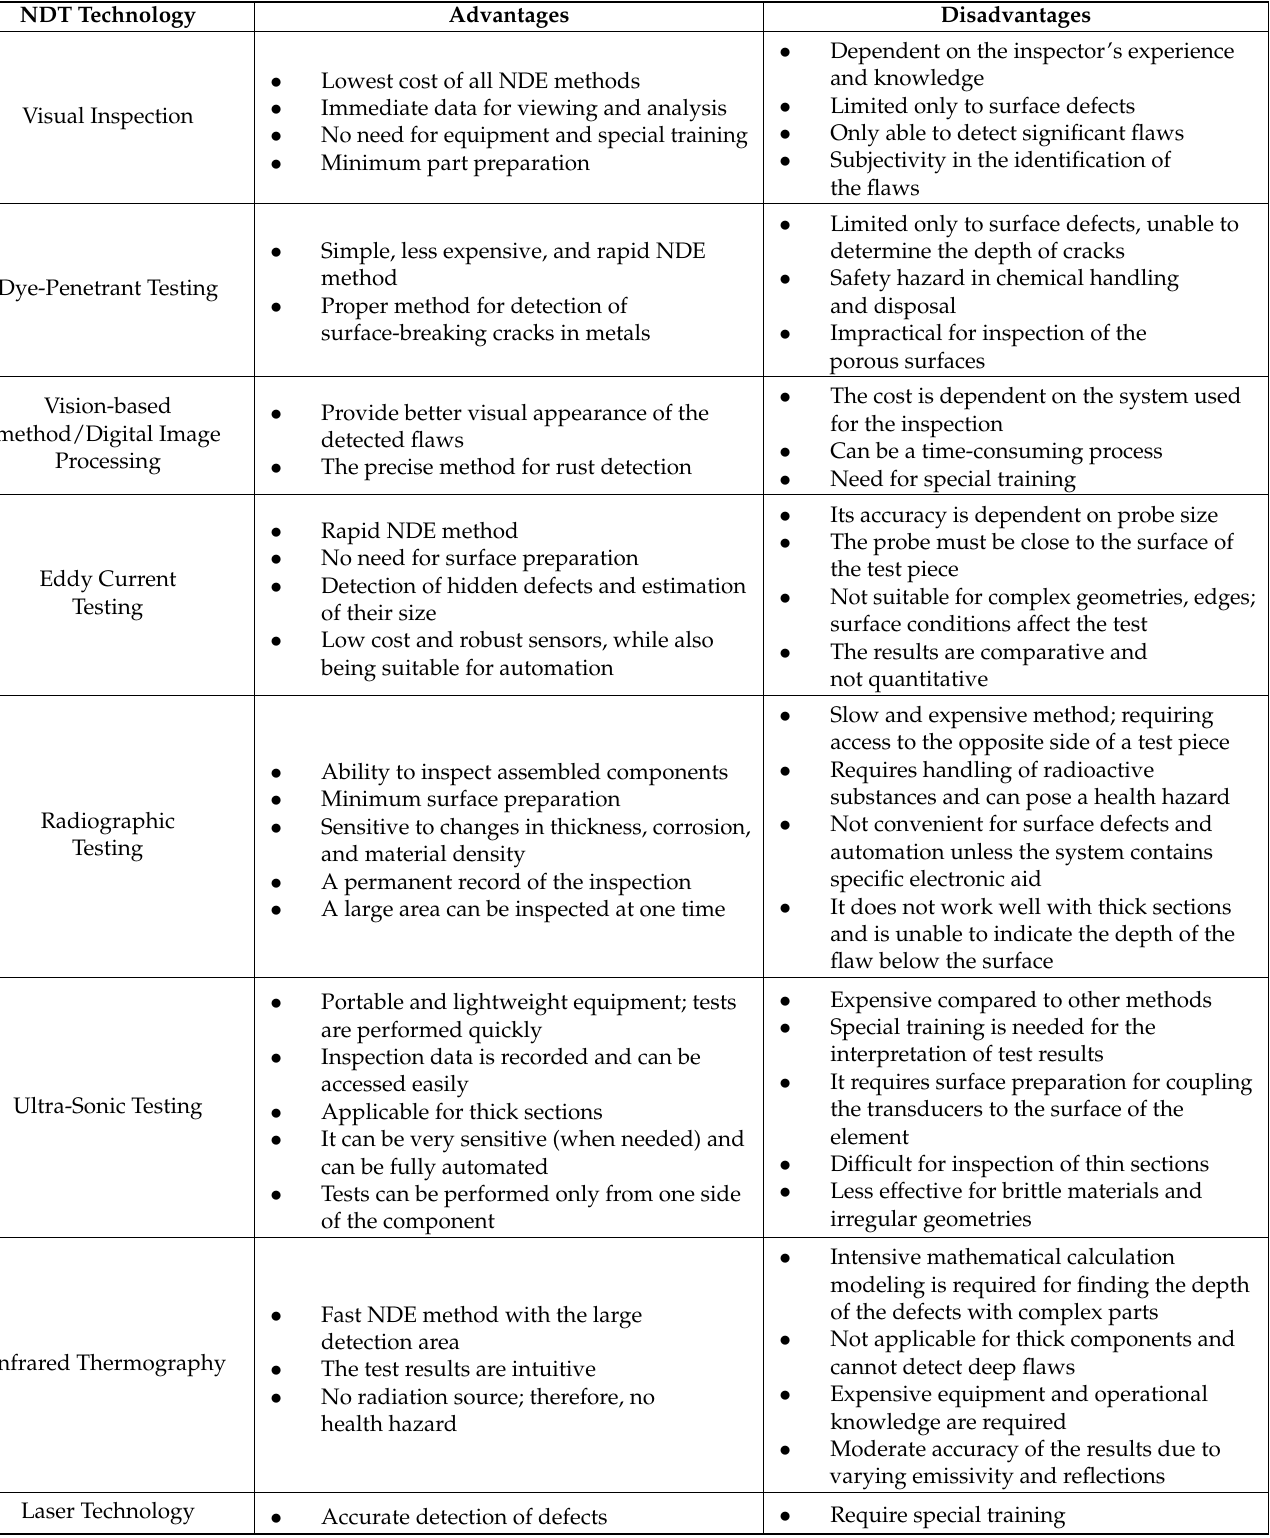
Table 3. Advantages and disadvantages of NDT methods discussed in this